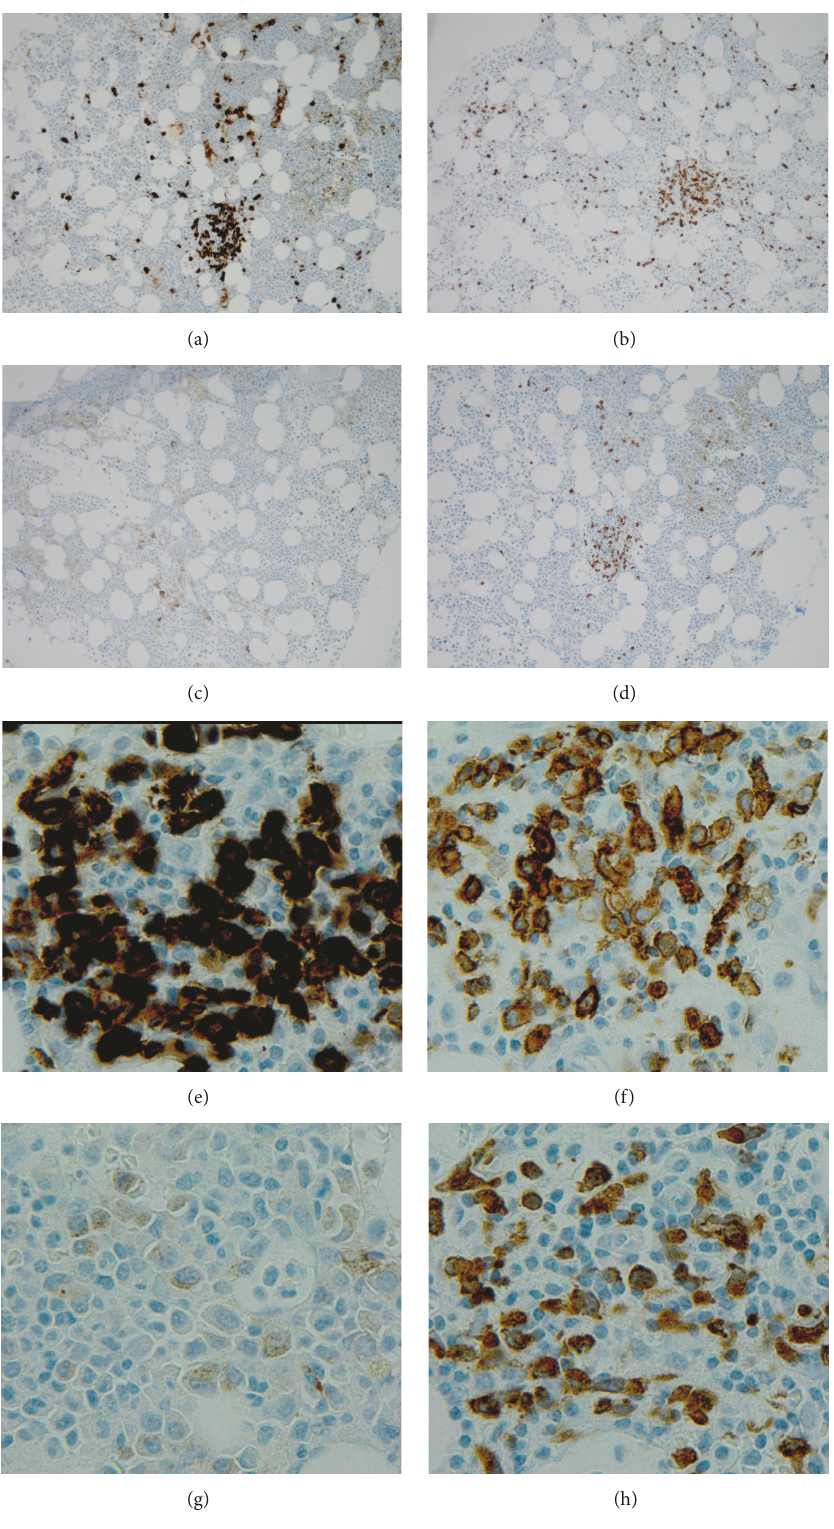
Figure 5: Immunohistochemistry staining of bone marrow core biopsy. Small to intermediate sized neoplastic cells form loose clusters and comprise 5–10% of marrow cellularity. These cells stain positive for CD30 (a, e), CD7 (b, f), EMA (equivocal) (c, g), and ALK (d, h). (a–d) 100x magnification; (e–h) 1000x